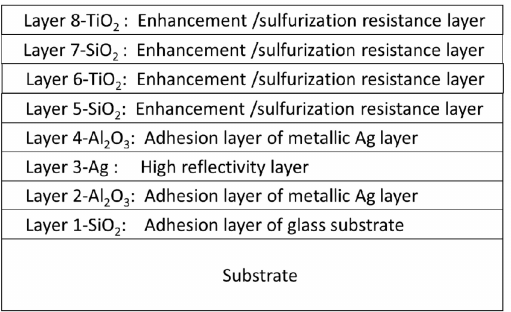
Figure 4. Schematic sketch of the functions at every layer in the Ag enhanced multilayer.